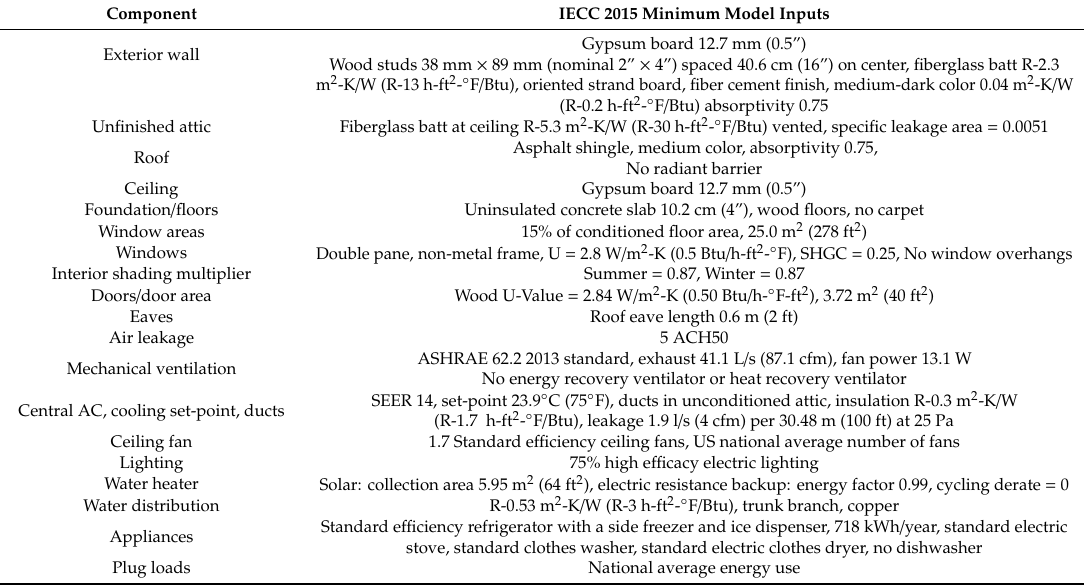
Table 2. The IECC 2015 model uses default BEopt TM assumptions for occupancy in order to represent a typical household. Table 2. Inputs in BEopt TM for the International Energy Conservation Code (IECC) 2015 minimum